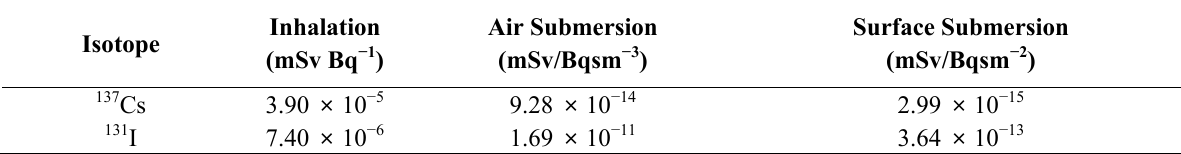
Table 1. Dose conversion factors for the estimation of exposure doses. Isotope